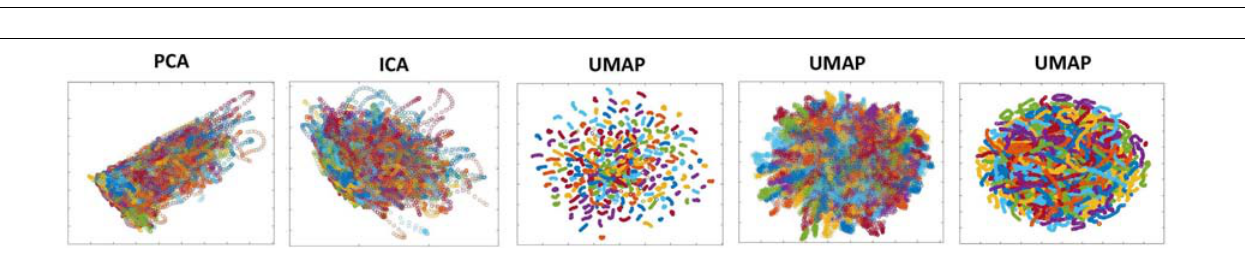
FIGURE 2 | Centroids from clustering time-resolved connectivity measures without in a time-blind manner. These are called “dFNC states.” For these data, as have been shown in previous publications (Damaraju et al., 2014; Miller et al., 2016c; Yaesoubi et al., 2017; Espinoza et al., 2019a; Rashid et al., 2019), there are five characteristic states that can be can be visually summarized as ranging from maximally modularized to weakly connected. Studies consistently show that schizophrenia patients spend more time in States 3 and 5 on average than do controls, whereas controls spend more time on average than patients in States 1, 2, and 4.